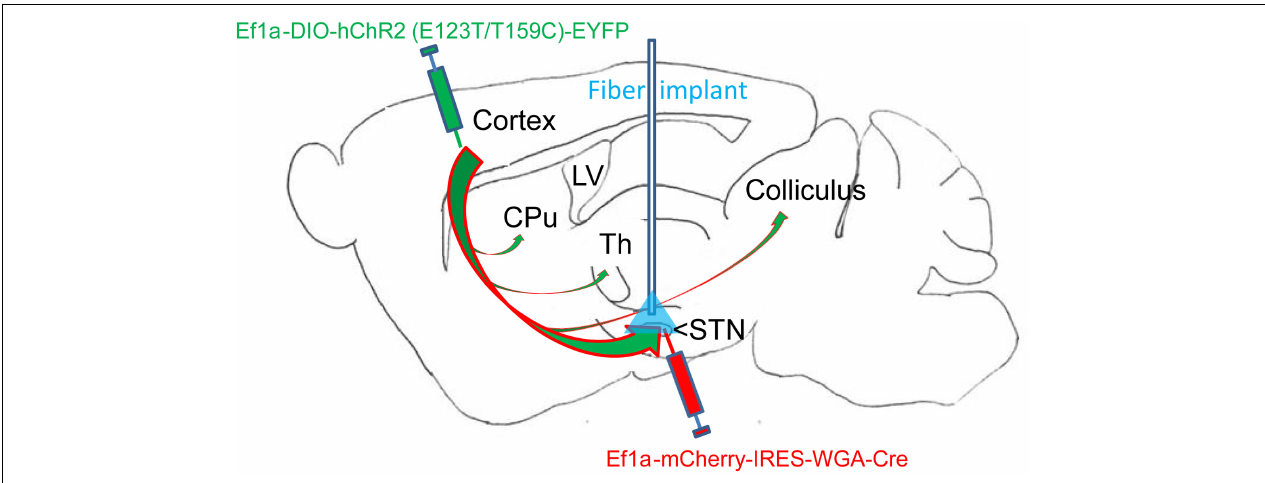
FIGURE 1 | Overview of dual virus injections and optogenetic fiber placement. Virus 1: Adeno-associated virus (AAVs) containing genetic constructs for Cre recombinase (Cre) conjugated to retrograde tracer (WGA) were injected in the subthalamic nucleus (STN). Virus 2: AAVs containing constructs for Cre-dependent ultrafast channelrhodopsin (ChR2) with EYFP fluorophore were injected in motor cortex (M1) layer 5. The two viruses together resulted in specific ChR2 placement in the layer 5 M1-STN projections transfected with retrogradely transported Cre from virus 1. The optogenetic fiber location for STN targeting is labeled in blue. M1-STN terminals and collaterals in striatum (CPu), thalamus (Th), and colliculus identified by EYFP tracing are marked with arrows.